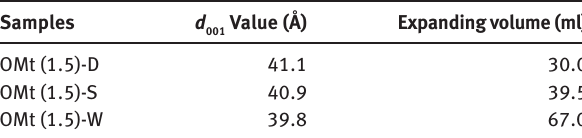
value and dispersibility. 001